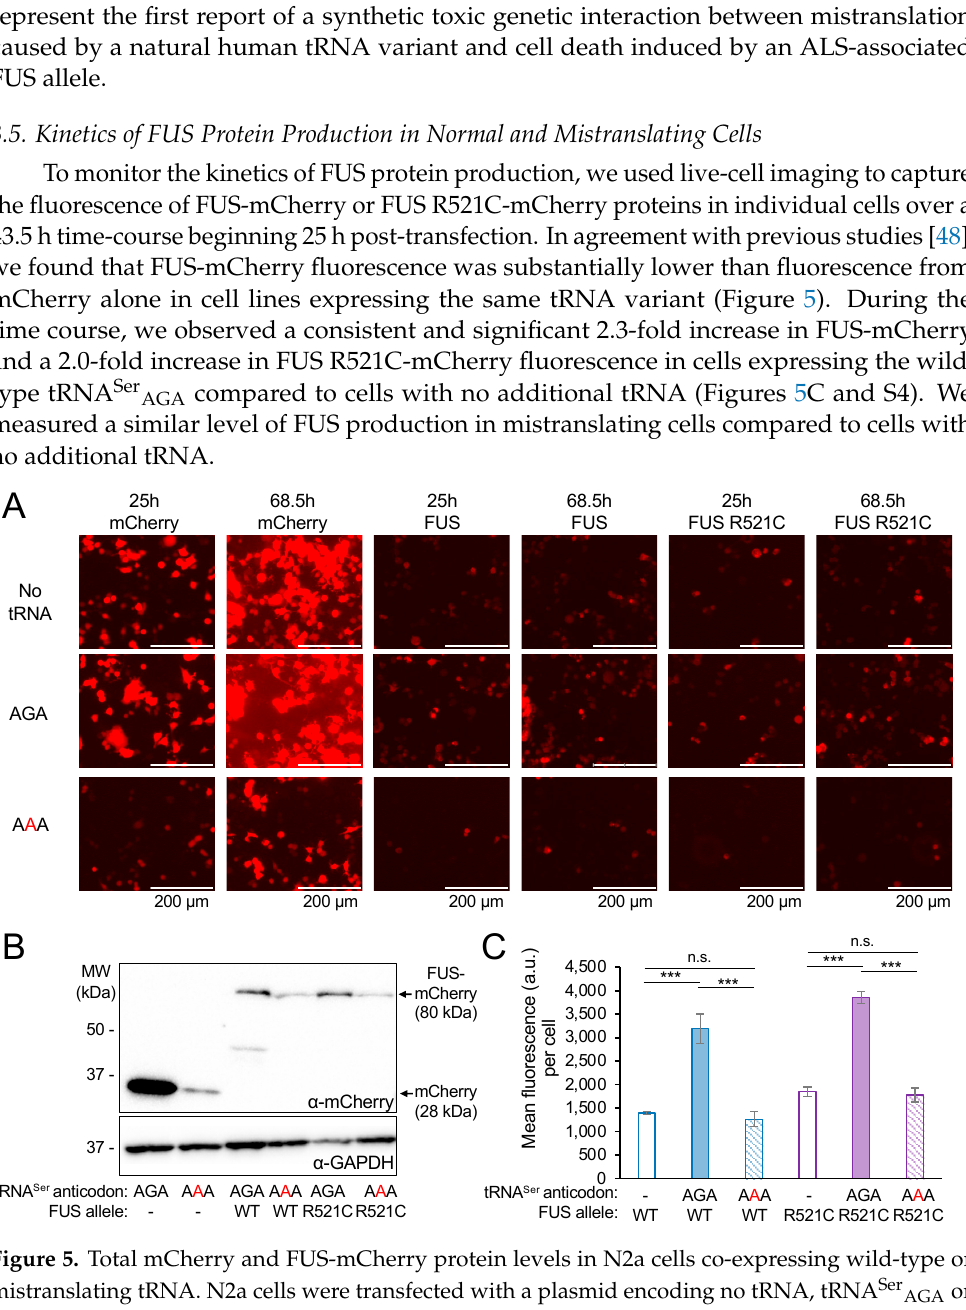
mean mCherry fluorescence per cell observed at the final (68.5 h) time point. Error bars represent the mean ± 1 standard deviation of at least five biological replicates. Significant differences from